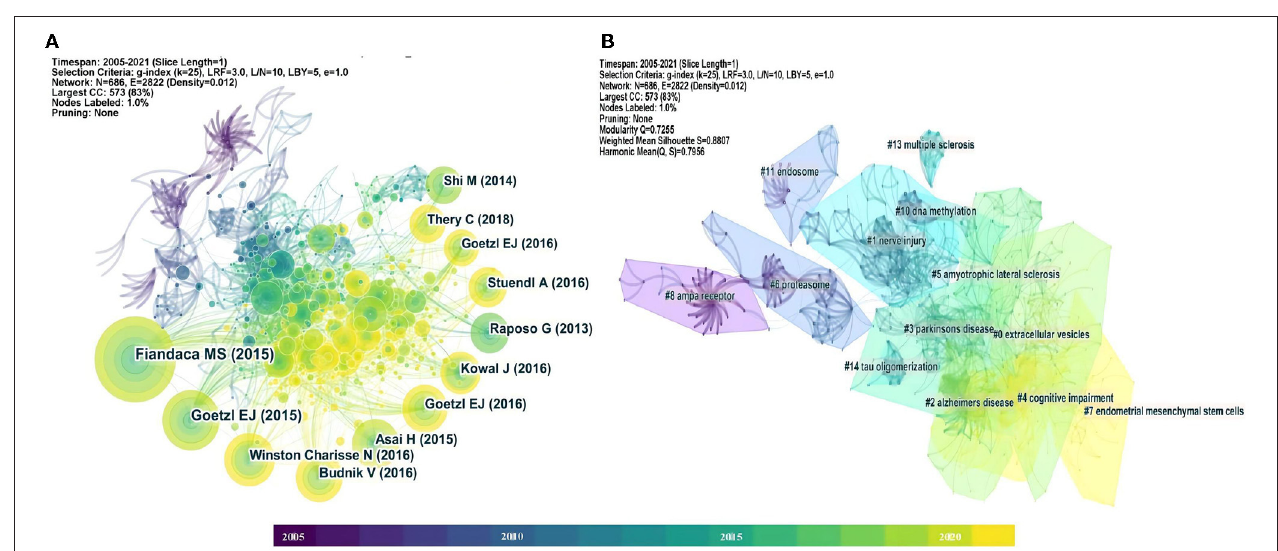
FIGURE 8 | (A) Co-citation analysis network about exosomes in the field of neuroscience. (B) Clustering analysis of co-citation network.